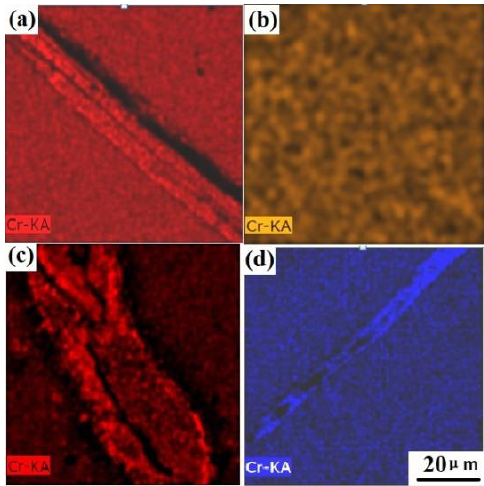
Figure 13. Chromium element distribution in the microcrack zone at different temperatures ( a ) 1050 °C, ( b ) 1100 °C, ( c ) 1150 °C, ( d ) 1200 °C.